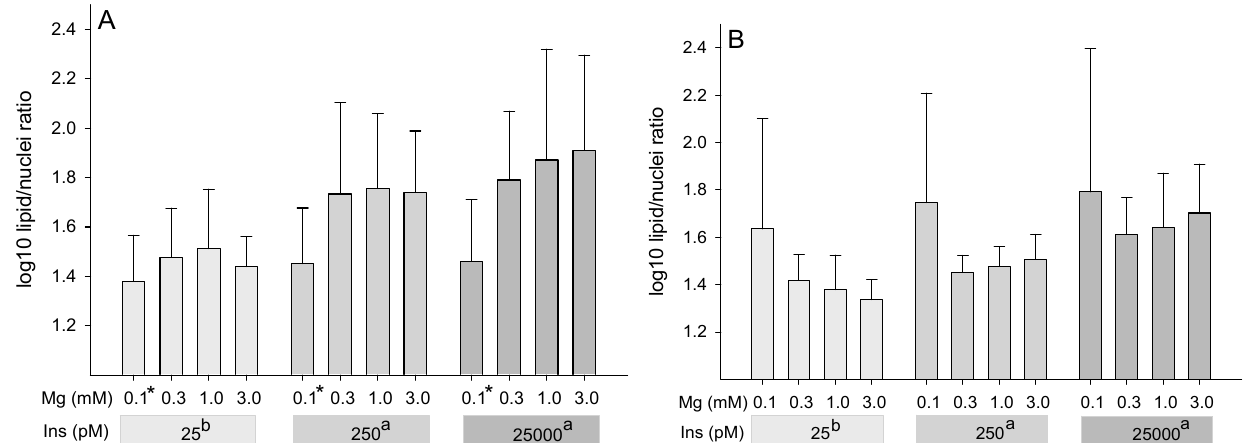
0.1 0.3 1.0 3.0 Figure 1. Quantification of non-polar lipids (ex. 475 nm/em. 570 nm) after 14 days ( A ) and after 21 days ( B ) in various Figure 1. Quantification of non-polar lipids (ex. 475 nm/em. 570 nm) after 14 days ( A ) and after 21 differentiation media containing different concentrations of magnesium (Mg) or insulin (Ins). Non-polar lipids are presented days ( B ) in various differentiation media containing different concentrations of magnesium (Mg) relative to dsDNA signal (DAPI fluorescence of nuclei ex.358 nm/em. 461 nm). Results are given as means ± SD of or insulin (Ins). Non-polar lipids are presented relative to dsDNA signal (DAPI fluorescence of six animals with two replicates per animal. * Asterisks indicate smaller LSM at 0.1 mM Mg compared to all other Mg concentrations ( P ≤ 0.05). a,b Different superscript letters indicate different LSM for the factor insulin ( P ≤ 0.05). nuclei ex.358 nm/em. 461 nm). Results are given as means ± SD of six animals with two replicates per animal. * Asterisks indicate smaller LSM at 0.1 mM Mg compared to all other Mg concentra- After 21 days of culture (Figure 1B), the log-transformed lipid/nuclei ratio was af- tions ( P ≤ 0.05). a,b Different superscript letters indicate different LSM for the factor insulin ( P ≤ fected by the factor insulin only ( P = 0.001). A supraphysiological insulin concentration Figure 1. Quantification of non-polar lipids (ex. 475 nm/em. 570 nm) after 14 days ( A ) and after 21 0.05) . (25,000 pM; LSM = 1.69 ± 0.034) showed the highest log-transformed lipid/nuclei ratio days ( B ) in various differentiation media containing different concentrations of magnesium (Mg) in comparison to a high physiological (250 pM; LSM = 1.55 ± 0.034) and the low (25 pM; or insulin (Ins). Non-polar lipids are presented relative to dsDNA signal (DAPI fluorescence of LSM = 1.44 ± 0.034) insulin concentration ( P ≤ 0.05 each). An insulin concentration of nuclei ex.358 nm/em. 461 nm). Results are given as means ± SD of six animals with two replicates 25 pM also tended to have lower log-transformed lipid/nuclei ratio compared to 250 pM per animal. * Asterisks indicate smaller LSM at 0.1 mM Mg compared to all other Mg concentra- ( P = 0.055). No effects of Mg ( P = 0.34) or Mg × insulin interaction ( P = 0.20) were observed tions ( P ≤ 0.05). a,b Different superscript letters indicate different LSM for the factor insulin ( P ≤ after 21 days in the differentiation medium. Representative images of lipid accumulation 0.05) . after 14 and 21 days at 1 mM Mg and different insulin concentrations are shown in Figure 2.